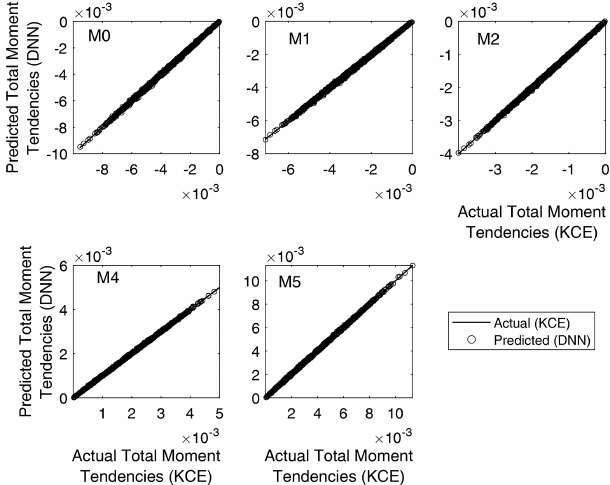
Figure 6. Regression plots for the five DNN trained. It is a compari- son between the outputs obtained from evaluating the trained neural networks using the test inputs and the targets from the validation data set corresponding to each of the total moment tendencies ob- tained from Eq. (13). The y axis varies for each panel because the plotted data are non-normalized.